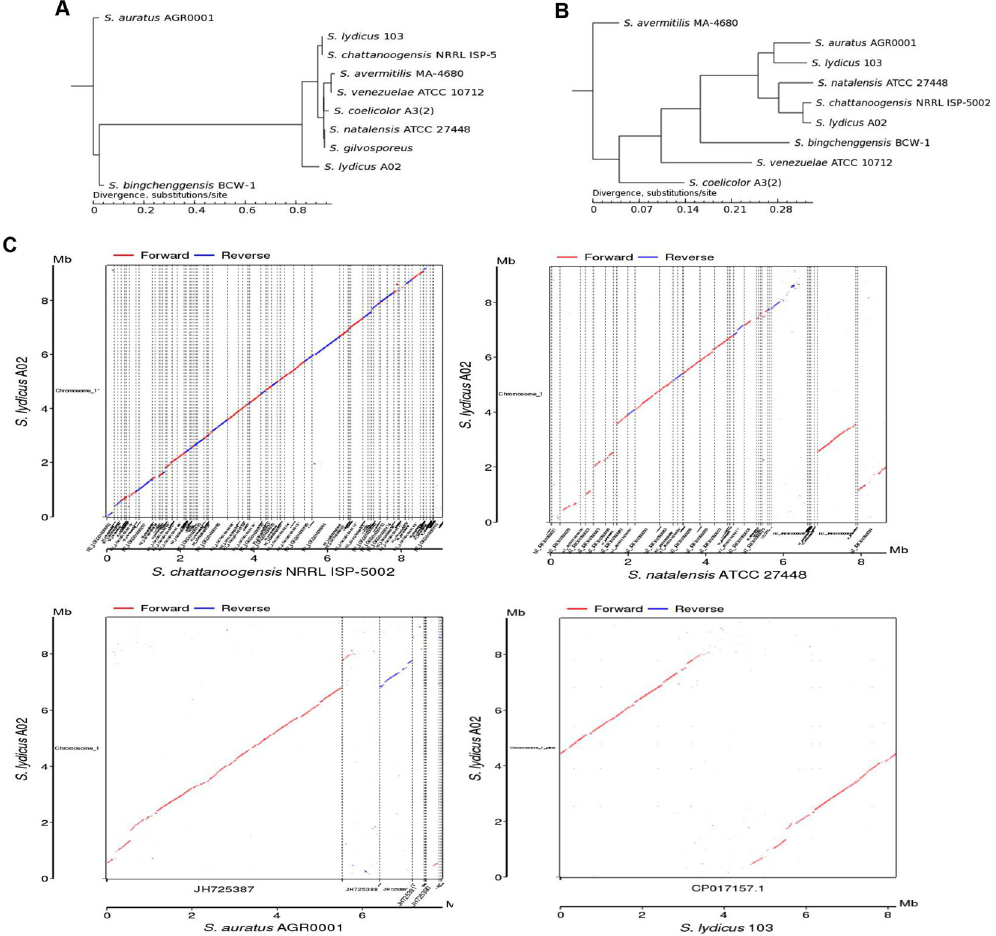
Figure 1. Phylogenetic trees for streptomycete. The phylogenetic tree is constructed by TreeBeST using PHYML based on ( A ) the 16 S rRNA gene and ( B ) the phylogenetic tree analysis’s result based on SNP analysis (core-fan genome and gene